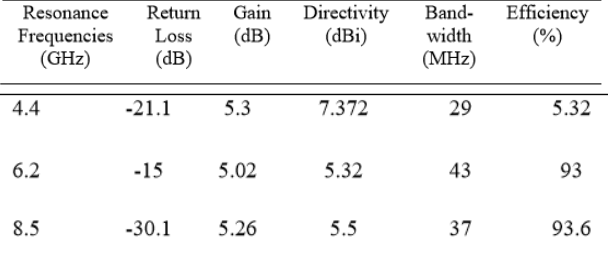
Table 3. Characteristics Parameters of Proposed